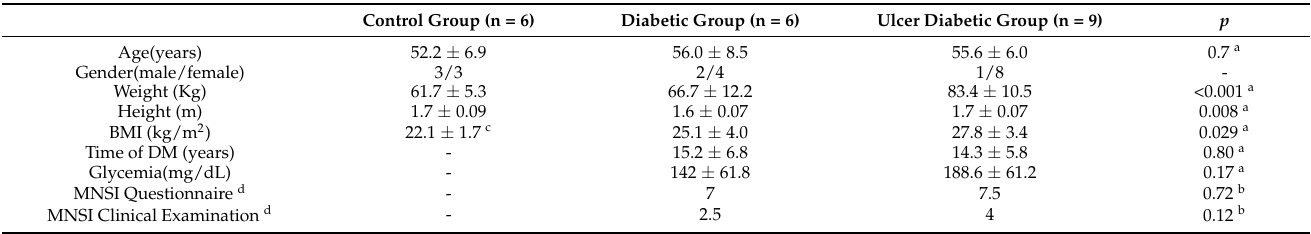
Table 1. Sociodemographic characteristics of the patients. Reprinted with permission from ref.